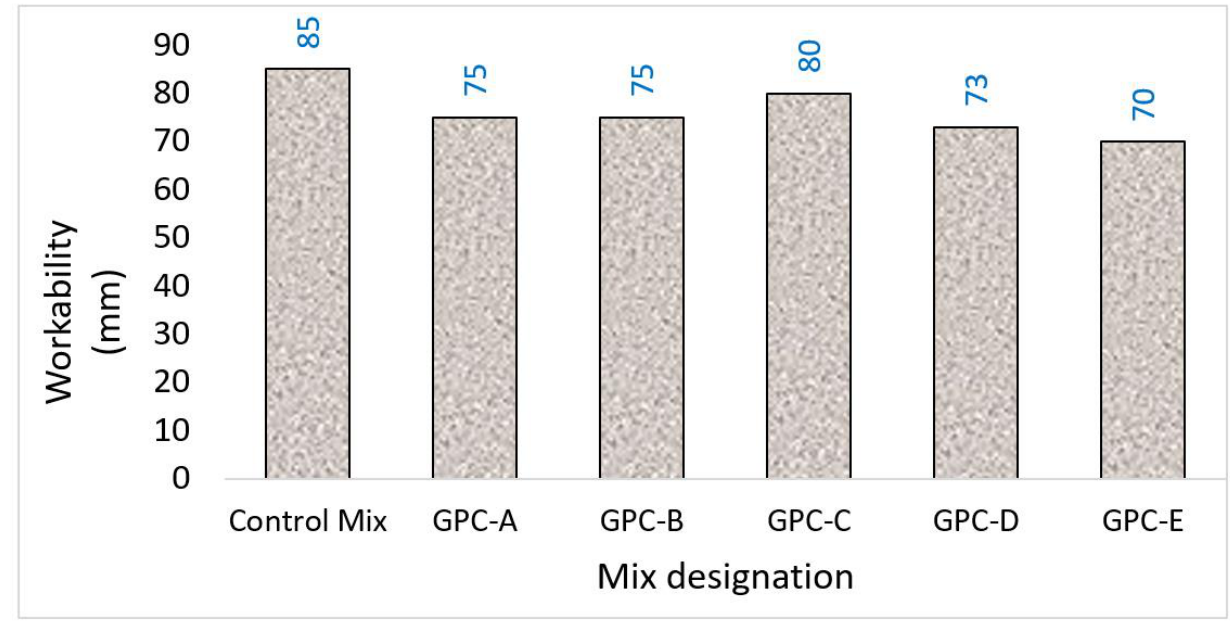
Figure 3. The slump values of control (OPC) and QFS-GPC mixes to the target slump (medium workable) after the addition of the varying amount of SP.